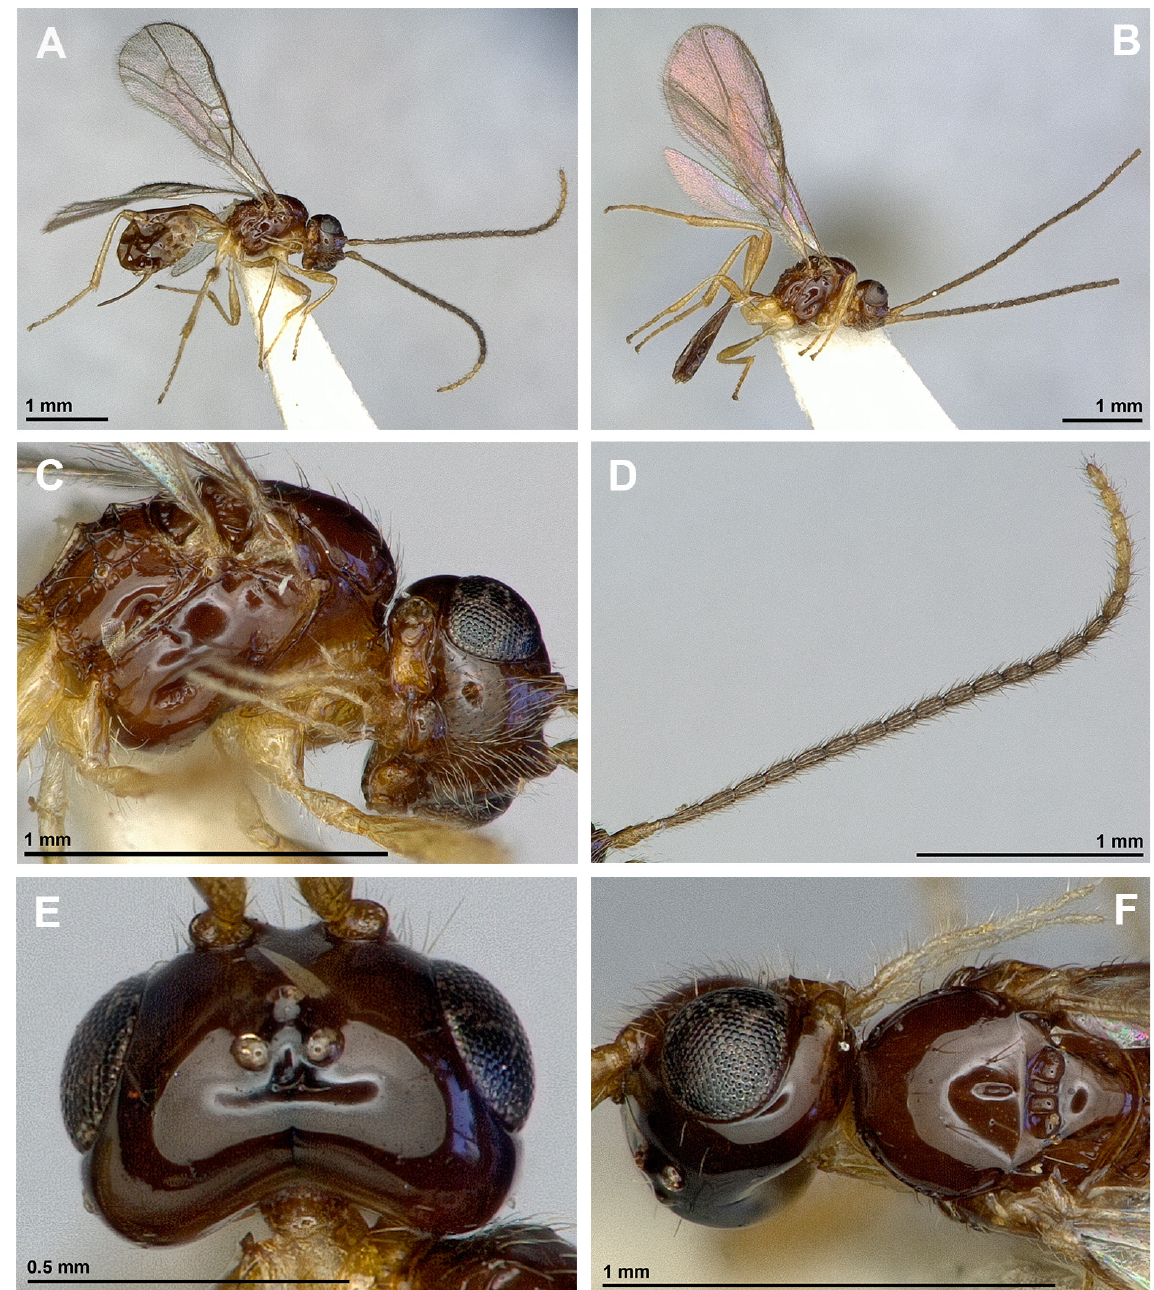
Fig. 3. Dinotrema plaumanni Peris-Felipo sp. nov. (A, C–F ♀; B ♂). A – B . Habitus, lateral view. C . Face, mandible and mesosoma in lateral view. D . Antenna. E . Head, dorsal view. F . Head, lateral view and mesonotum, dorsal